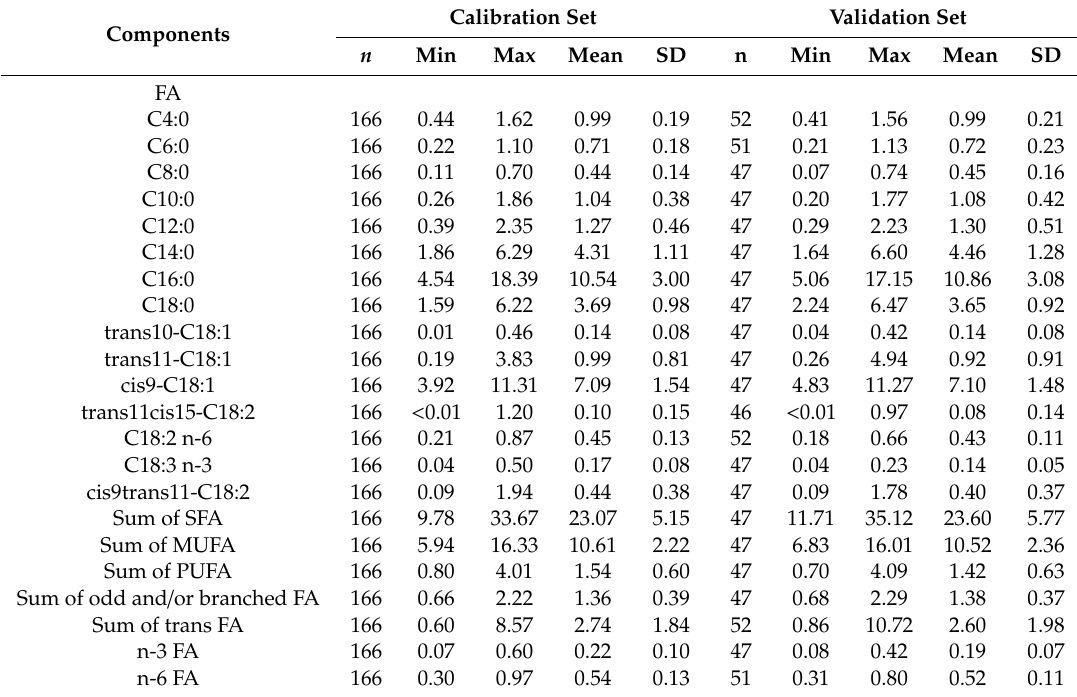
Table A1. Descriptive statistics of selected fatty acids (FA, expressed in g fat / kg of milk) in the calibration and validation sets used for near-infrared, mid-infrared and fluorescence spectroscopy